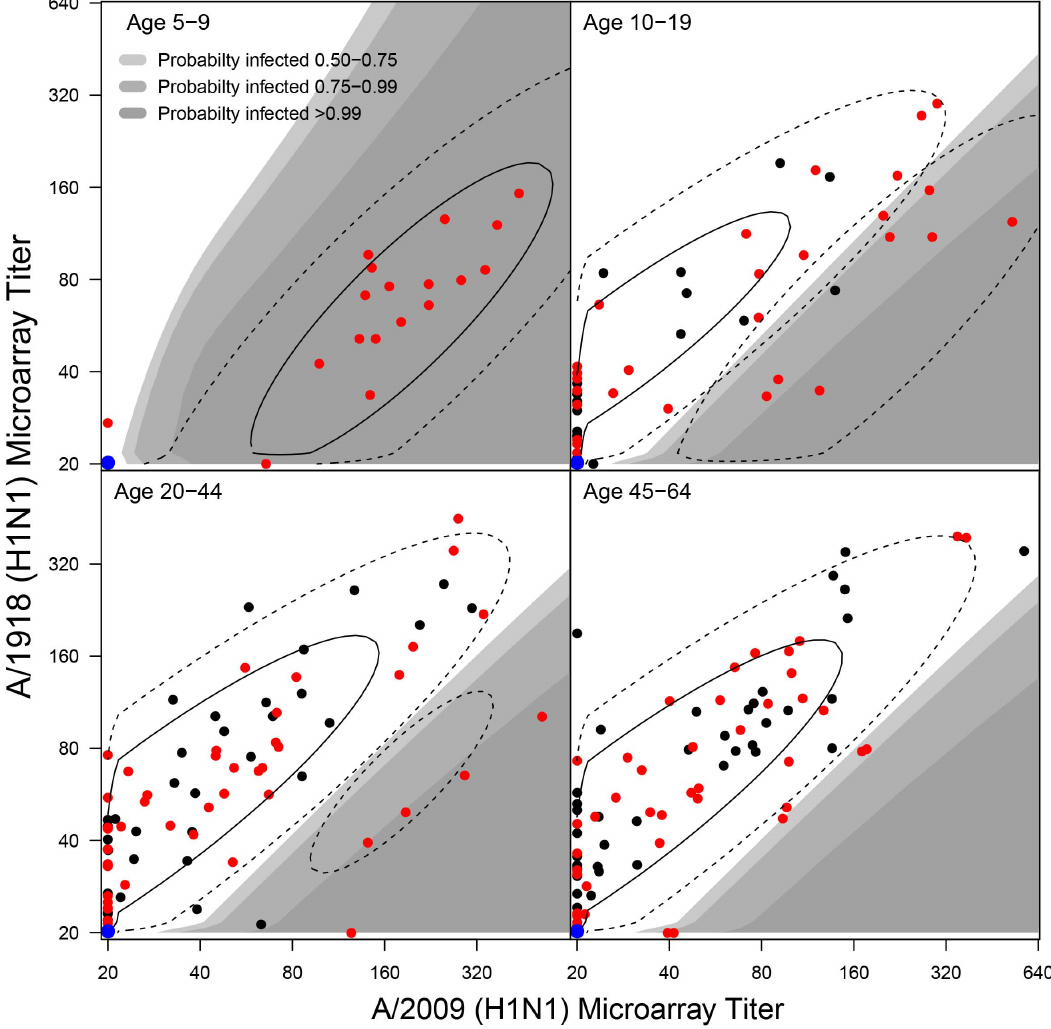
Figure 3. Model fit of bivariate H1N1 microarray data (A/2009 versus A/1918). Black and red dots represent the data, i.e. pre- and post- pandemic samples. Contours indicate the densities of the immune and infected distributions weighted by the the estimated age-specific infection probabilities (Table 3). The blue dots indicate that multiple samples are negative to both A/1918 and A/2009 (age-specific numbers in the pre- pandemic survey: 15, 20, 16, 19; post-pandemic survey: 9, 19, 19, 17). Grey areas indicate the regions with high probabilty that a post-pandemic sample is infected with A/2009. The susceptible component is placed largely placed beneath the detection limit and is not displayed.